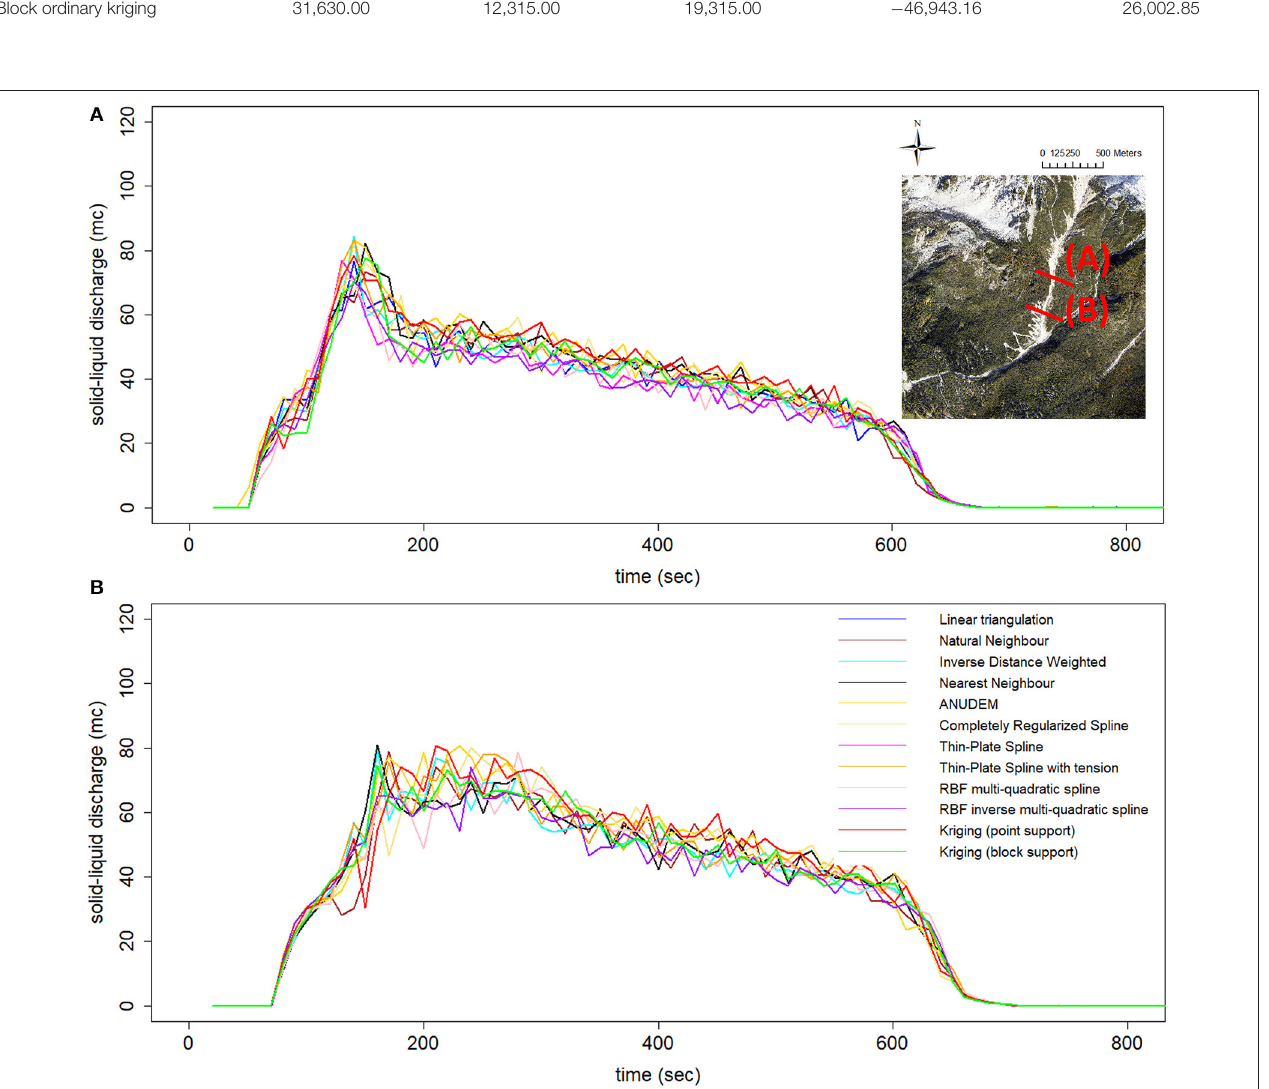
FIGURE 11 | Comparison of the simulated debris flow solid-liquid hydrographs ( A , upstream section, and B , downstream section).